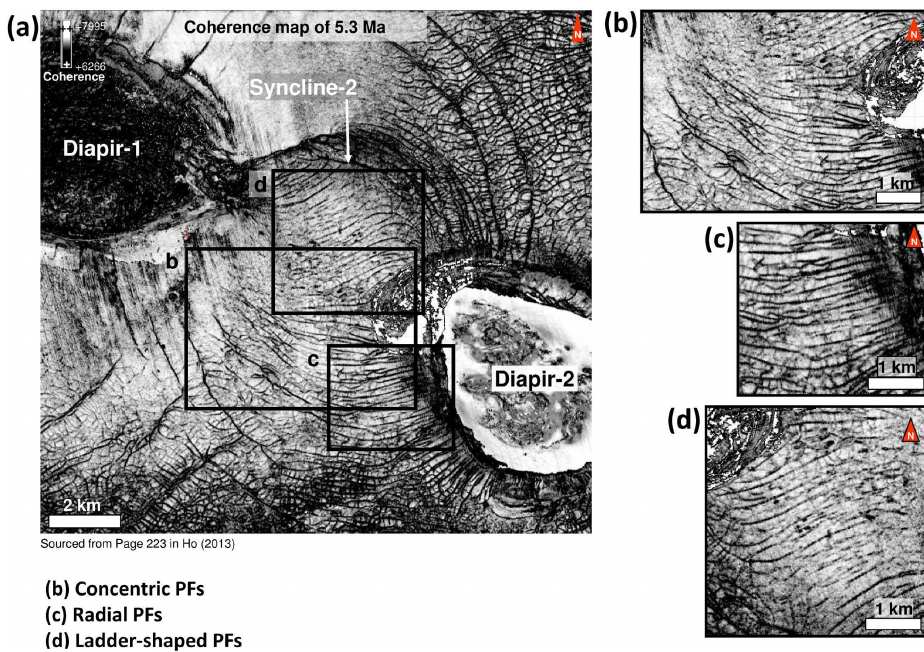
Figure A2. Different patterns of anisotropic PF networks in which Linear Chimneys are found. (a) Coherence attribute extracted onto the basal surface of PF Tier-2 showing the geometry and preferential alignment of PFs in withdrawal Syncline-2 and around Diapir-1 and -2. (b–d) Close-ups of the map in (a) . Locations of maps are shown by coloured squares. Sourced from page 223 in Ho